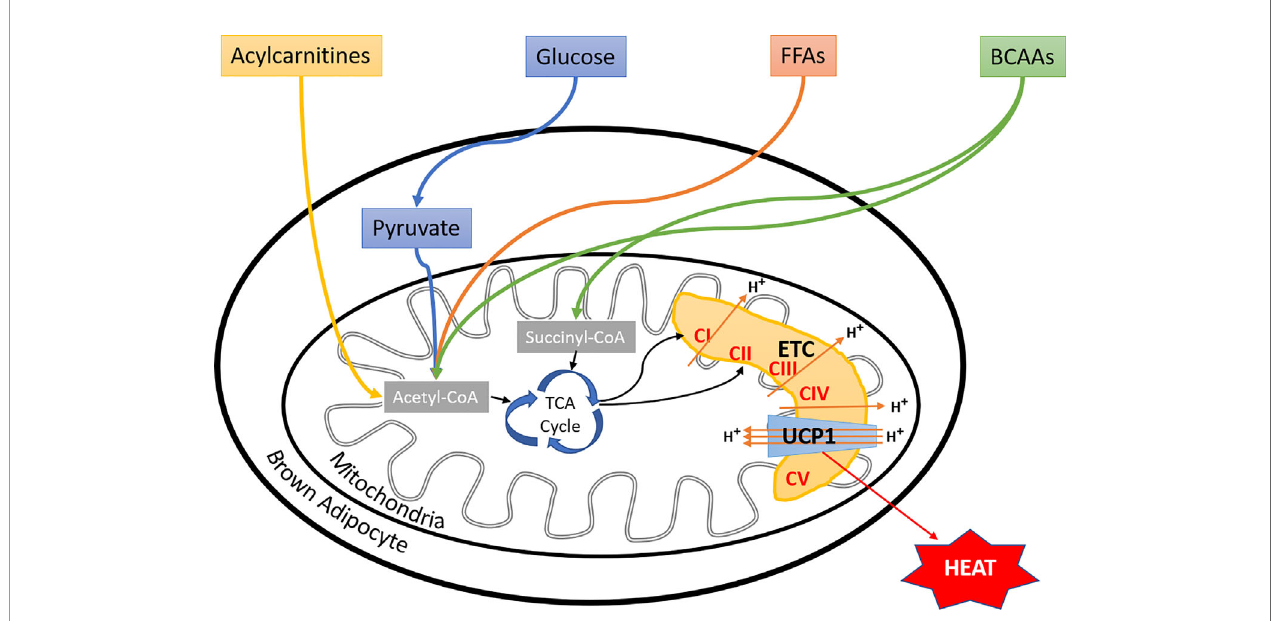
FIGURE 2 | Fuel selection by brown adipocyte. Besides glucose and fatty acids, BAT utilizes a variety of substrates, including BCAAs, succinate, and liver-derived acylcarnitines to fuel thermogenesis, more substrates to be discovered in the near future. However, the regulatory mechanisms of brown adipocyte fuel selection, especially upon environmental temperature changes, and whether aging or metabolic disorders affect these processes remain unknown. FFAs, free fatty acids; BCAAs, branched-chain amino acids; ETC, electron transport chain; CI, complex I; CII, complex II; CIII, complex III; CIV, complex IV; CV, complex V; UCP1, uncoupling protein